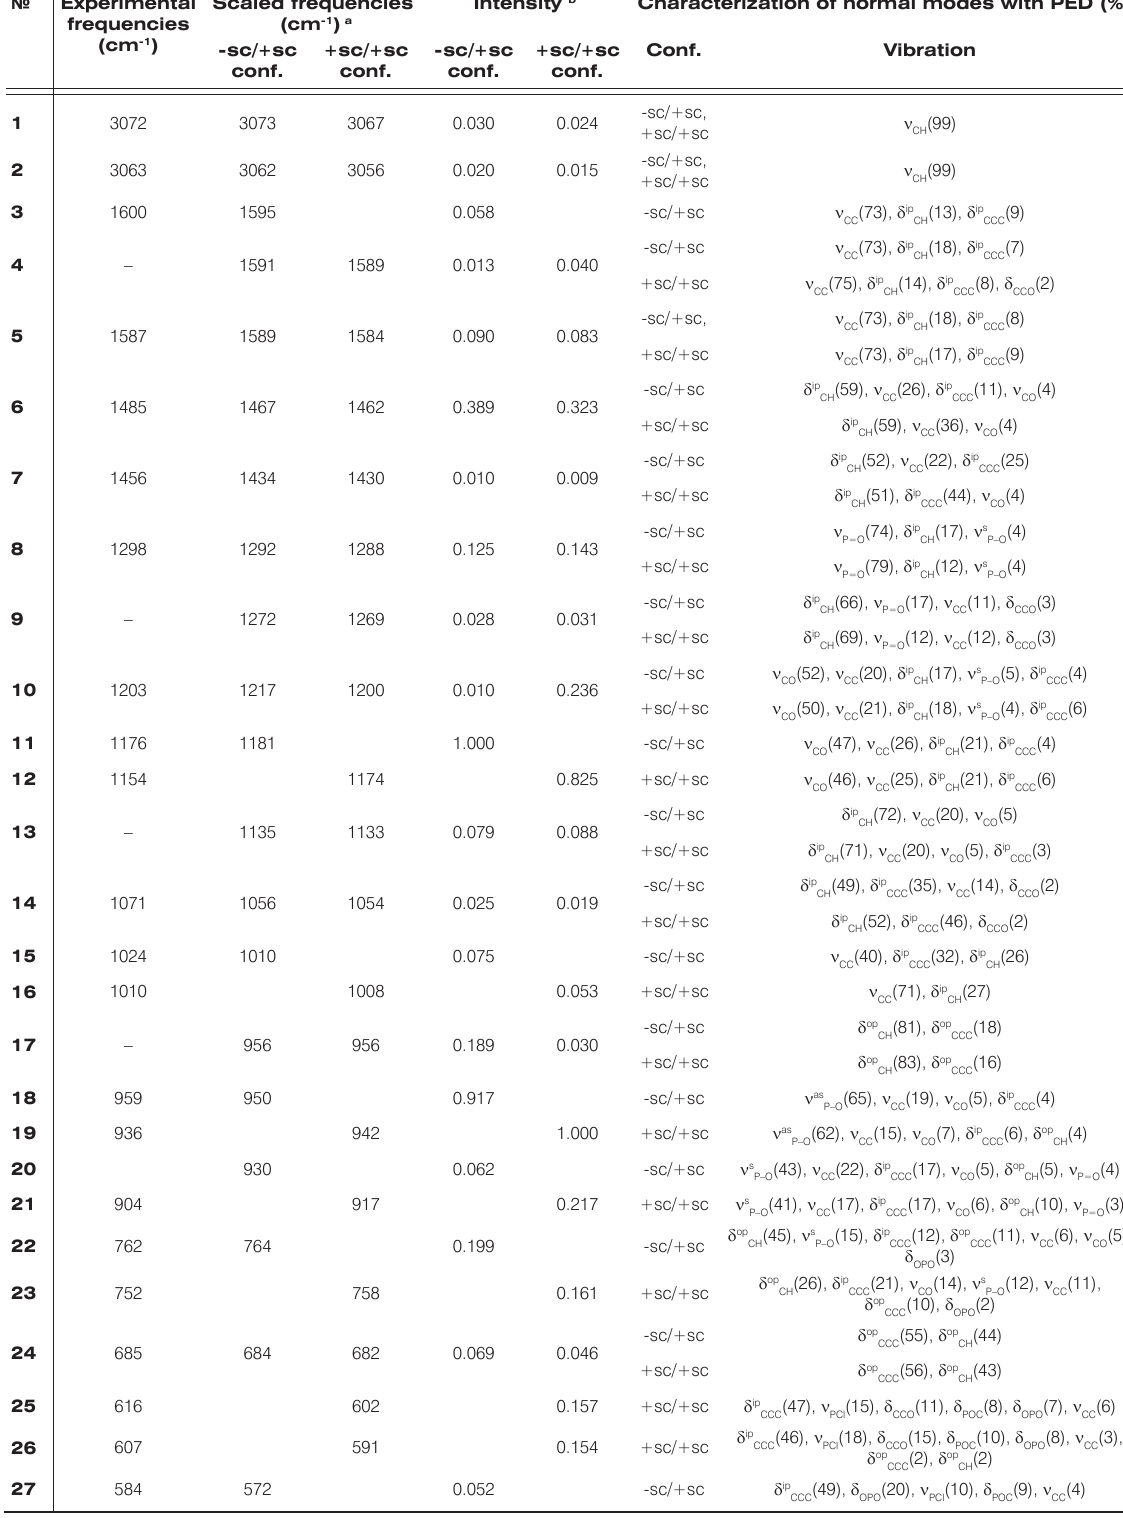
Table 4. Assignments of fundamental vibrations of diphenyl chlorophoshate. № Experimental frequencies